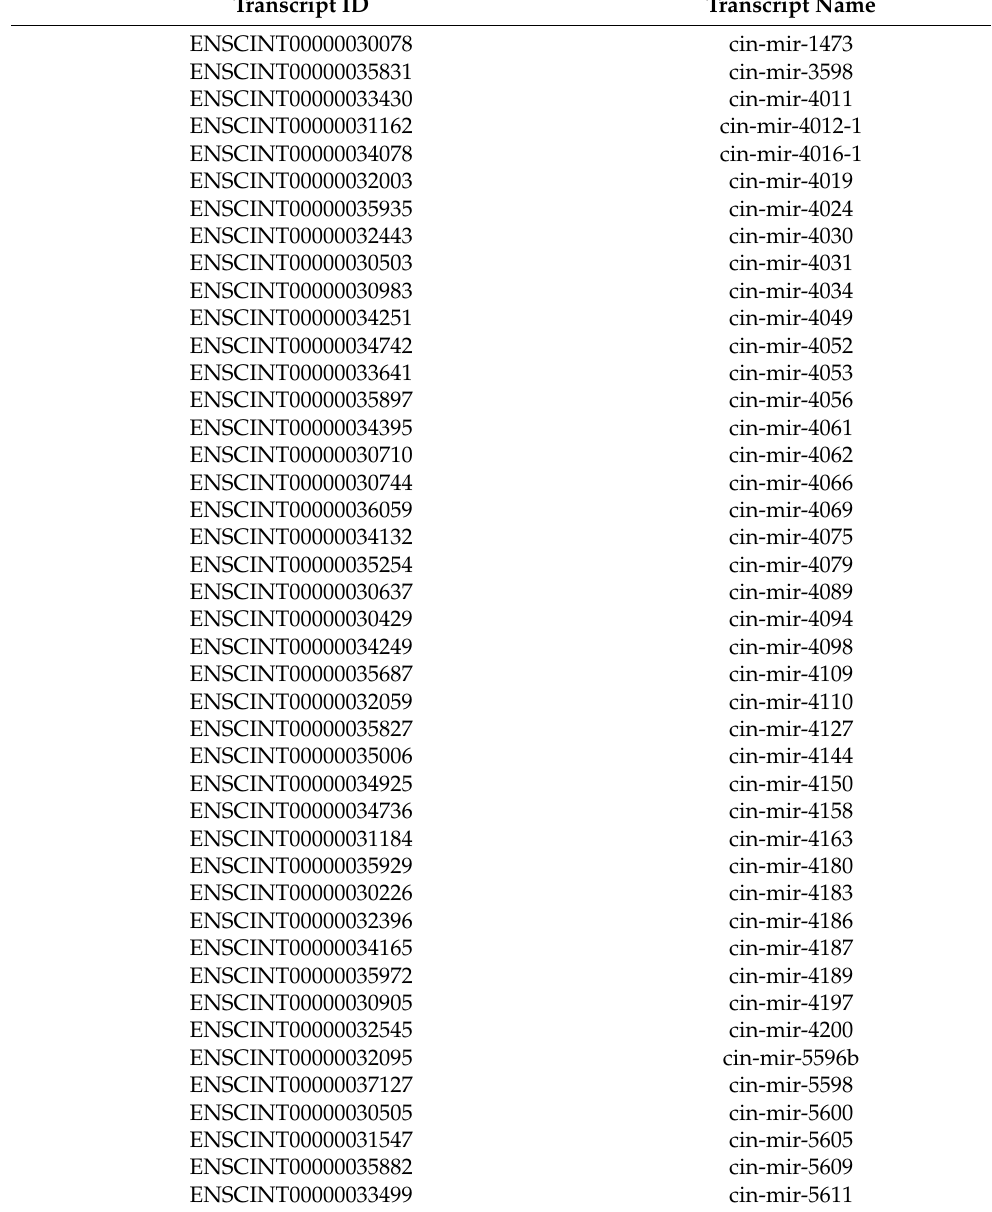
Table 2. Species-specific